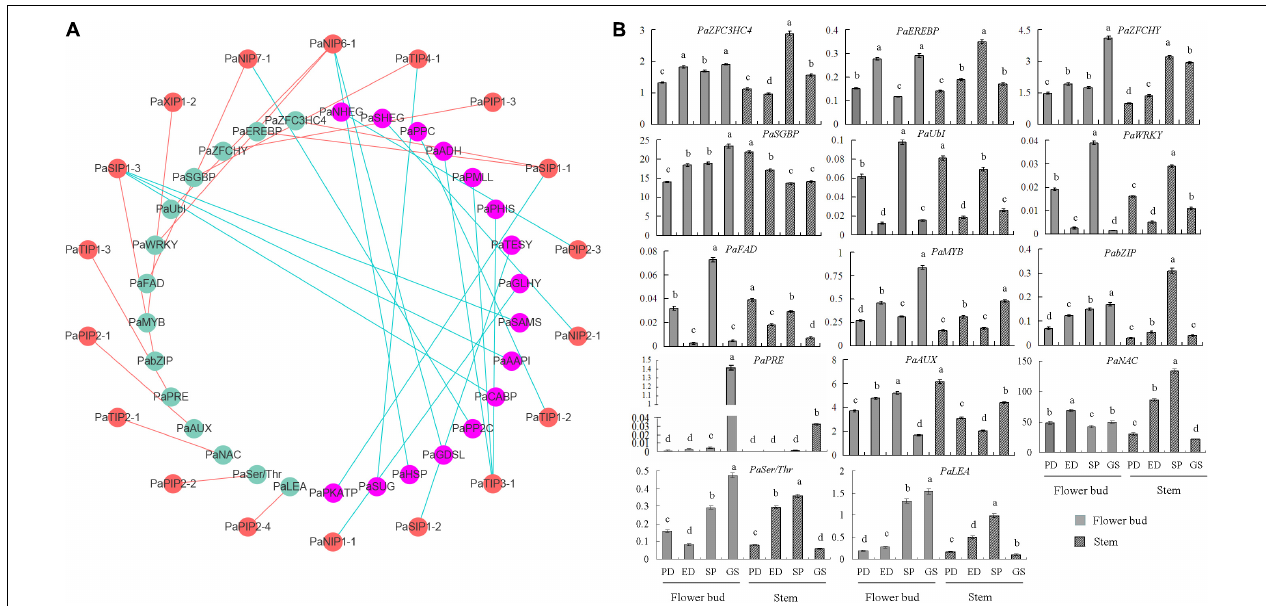
FIGURE 6 | PaAQP coexpression network. (A) Among the 1,500 genes coexpressed with PaAQPs , 14 (green nodes) are involved in cold resistance based on previous research. In addition, the anticold ability of 16 genes (pink nodes) is not very clear. The red node is the PaAQP genes. Cyan lines represent PaAQPs coexpressed with 14 cold resistance genes, and red lines represent PaAQPs coexpressed with 16 cold stress-associated genes. (B) Transcript levels of 14 genes involved in cold resistance in stem and flower buds during the PD stage, ED stage, SP stage, and GS stage of P. armeniaca . All expression levels of the PaAQP genes were normalized to those of PaElf . Each bar represents the mean ± SD of three technical replicates. The different letters represent significant differences at P < 0.05 (one-way